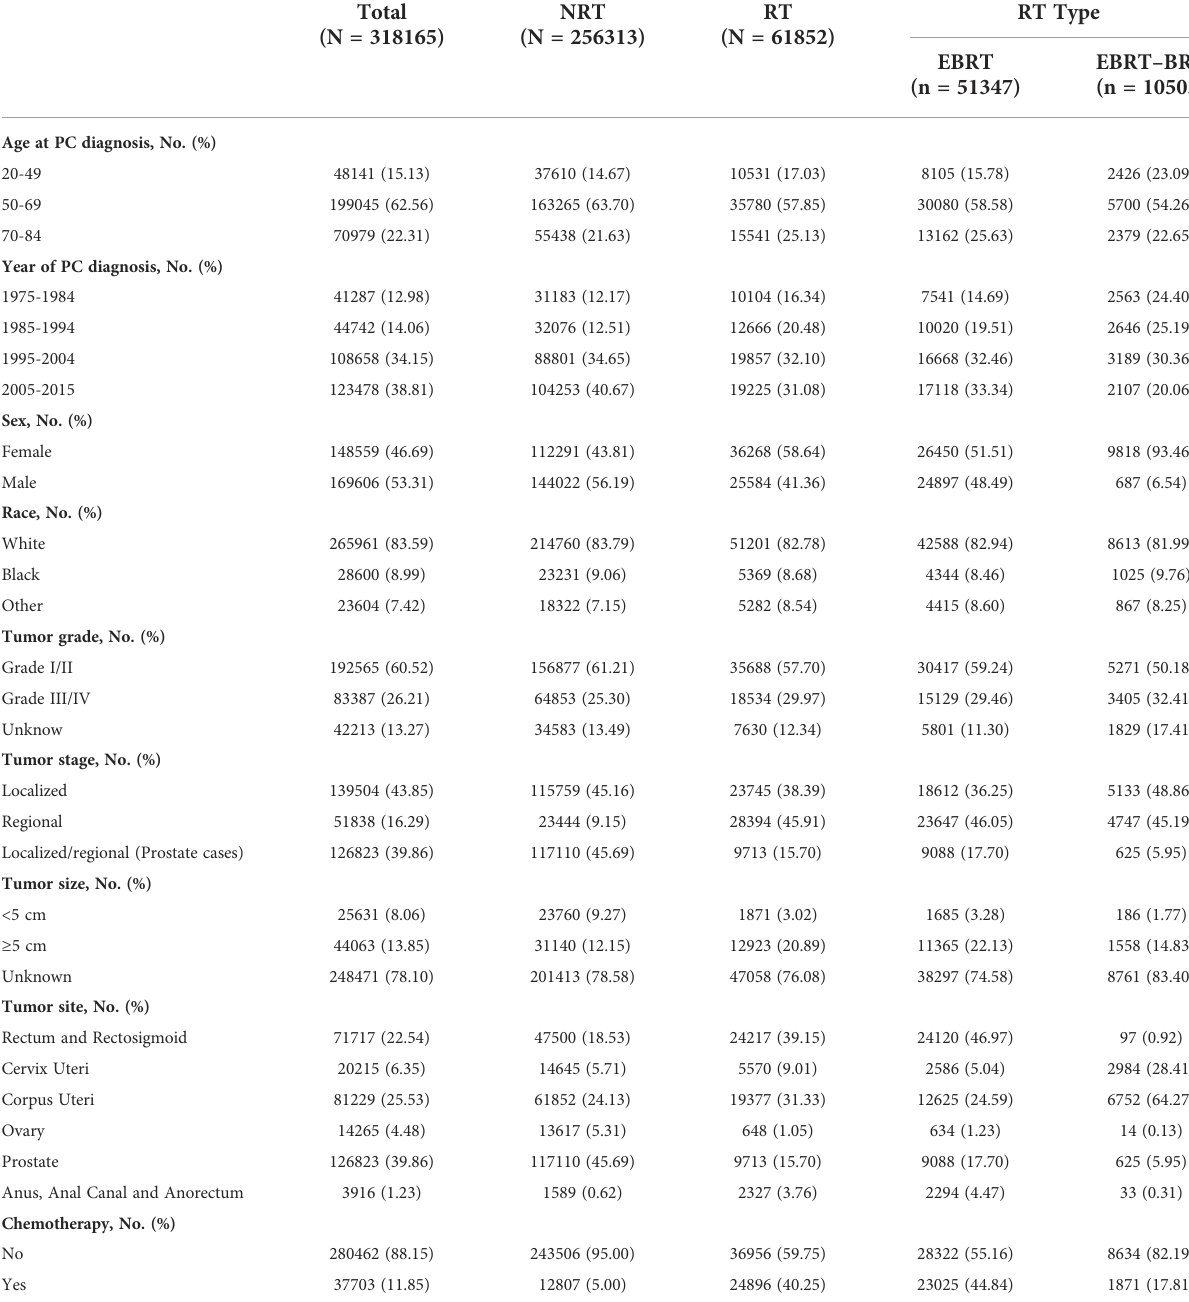
TABLE 1 Comparisons of Baseline Characteristics of Patients with PC by Treatment